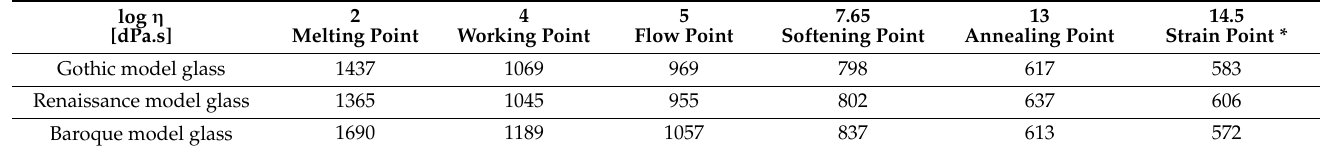
Table 5. Reference viscosity points for model glasses [ ◦